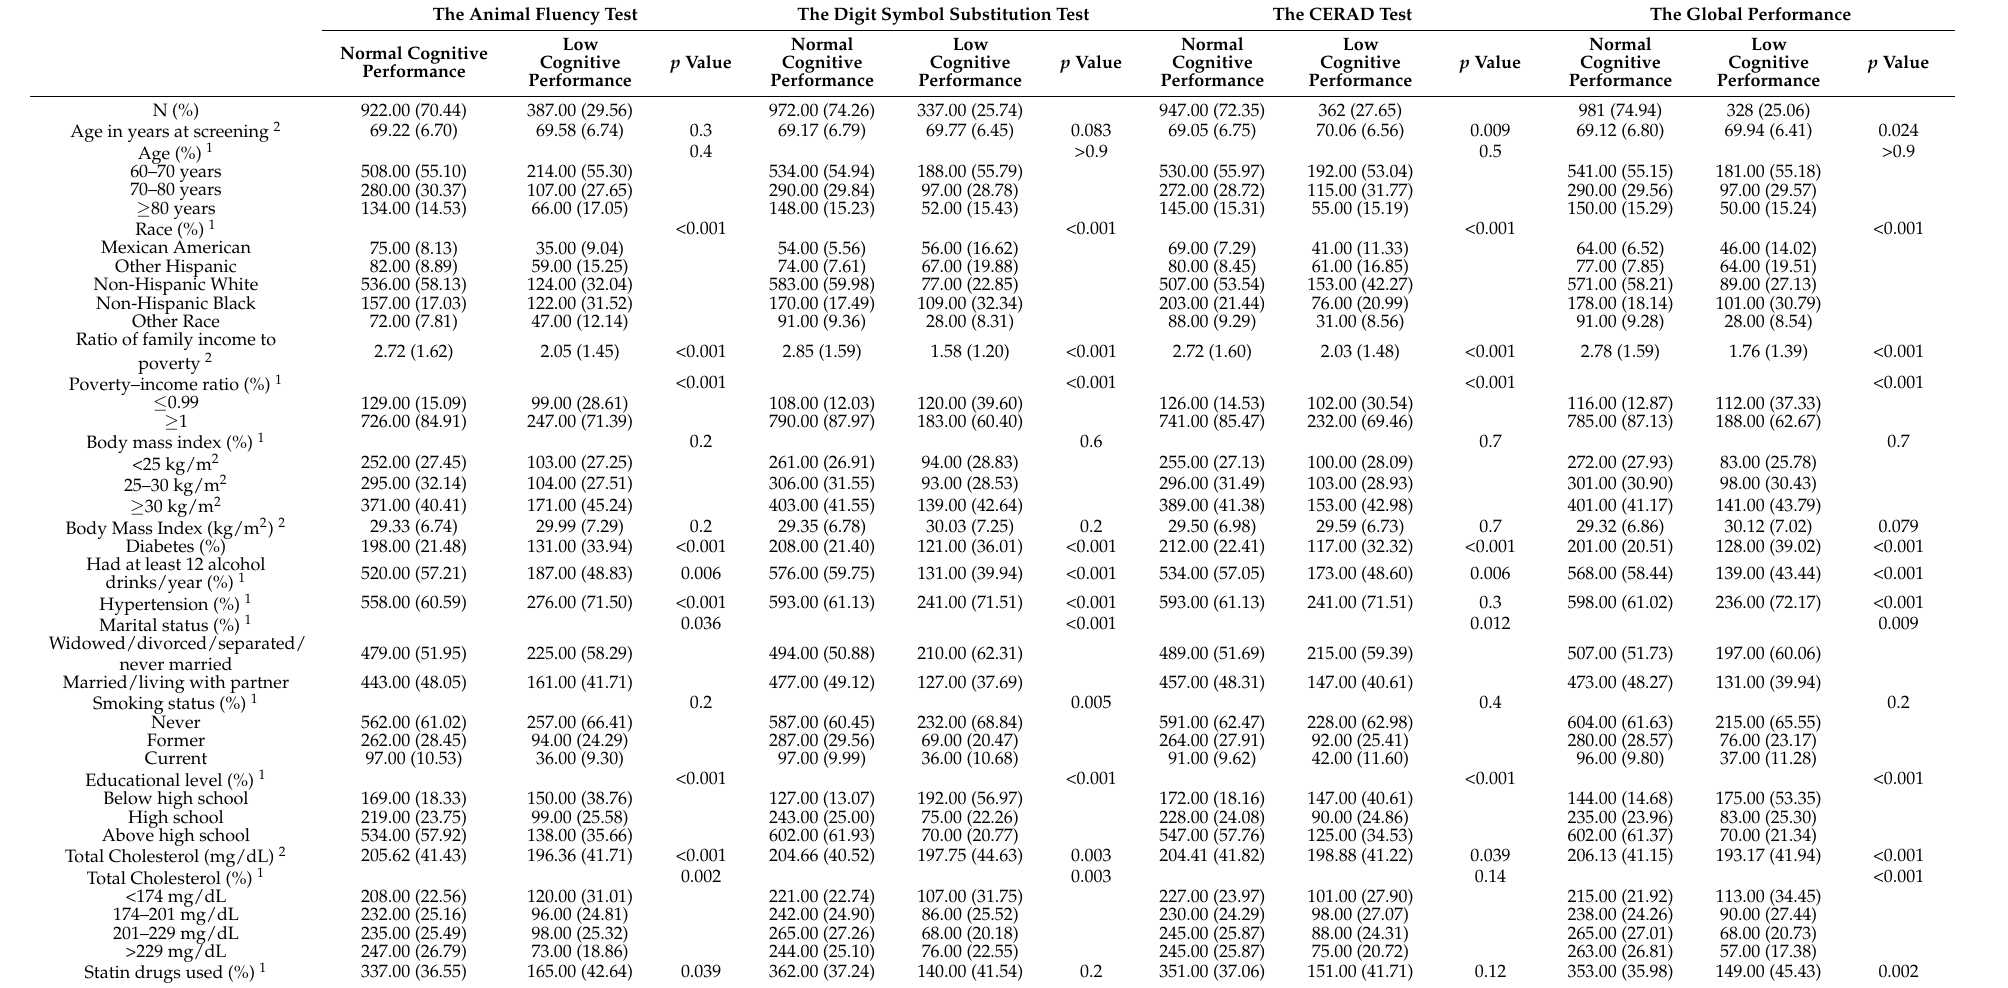
Table 2. Characteristics of the female population ( N =